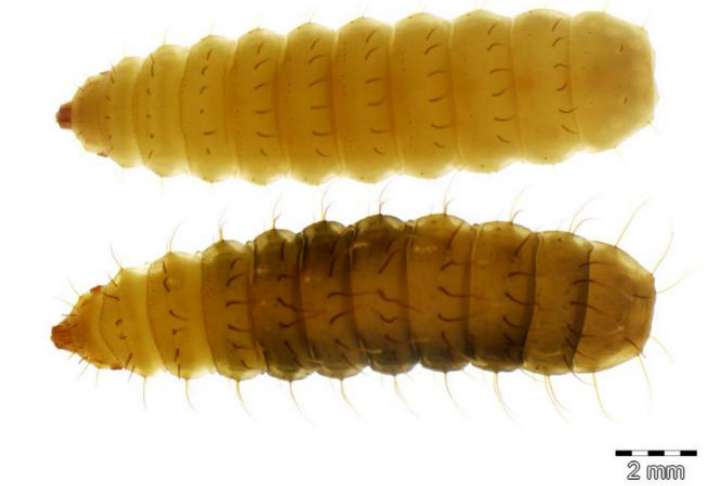
Figure 3. Habitus of the stratiomyid larvae of Hermetia illucens ( top ) and H. fenestrata ( bottom ) in dorsal